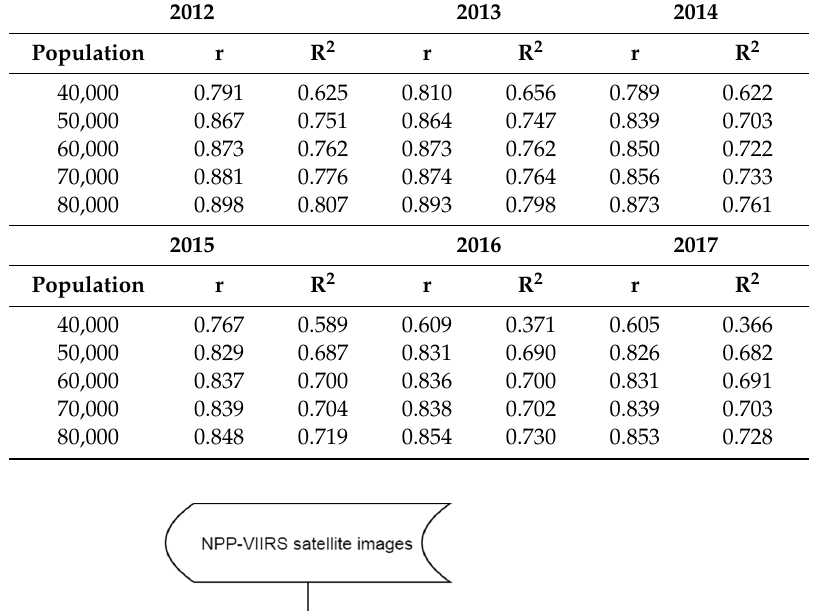
Table 1. Pearson correlation coe ffi cient and R-squared between Sum of Light and local tax income (RON / person).